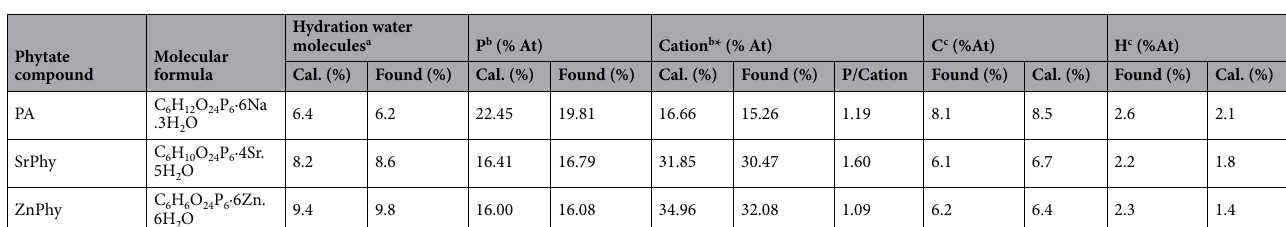
Table 1. Molecular empiric formula obtained for PA and the metallic derivatives, SrPhy and ZnPhy, as determined by High Resolution Thermal Gravimetric analysis (HRES-TGA), Inductively Coupling Plasma- Atomic emission spectroscopy (ICP) and microanalysis. a Determined by HRES-TGA, b Phosphorous as determined by ICP, c Carbon and hydrogen as determined by microanalysis *Refers to Na + , Sr 2+ or Zn 2+ for PA, SrPhy or ZnPhy respectively.